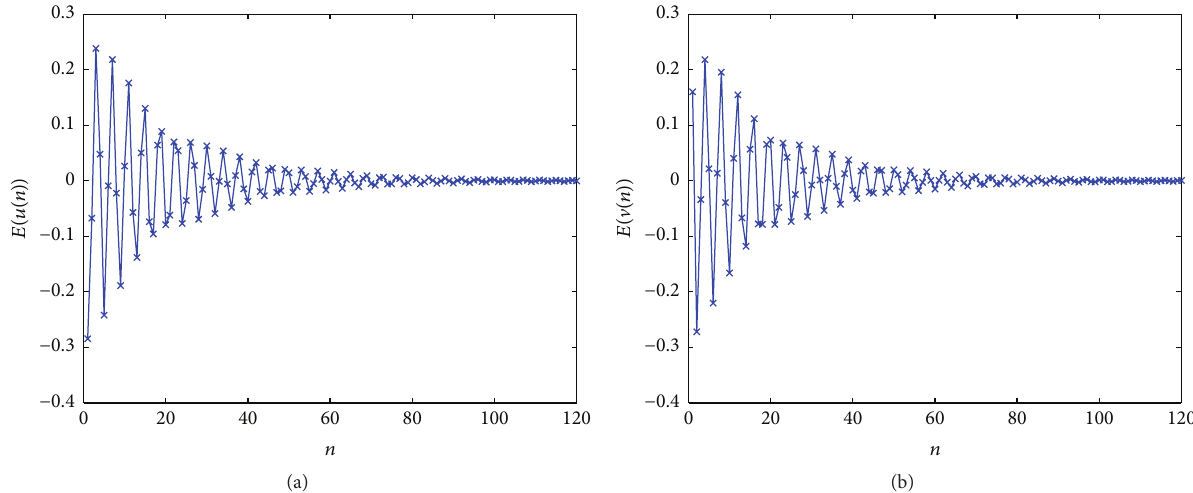
Figure 5: Time history diagrams of the controlled delayed species model (21) for 𝛿 = 0.001 , 𝑘 4 = 0.1 . The initial values are [𝑢(0) = 0.2, V (0) = 0.2] .